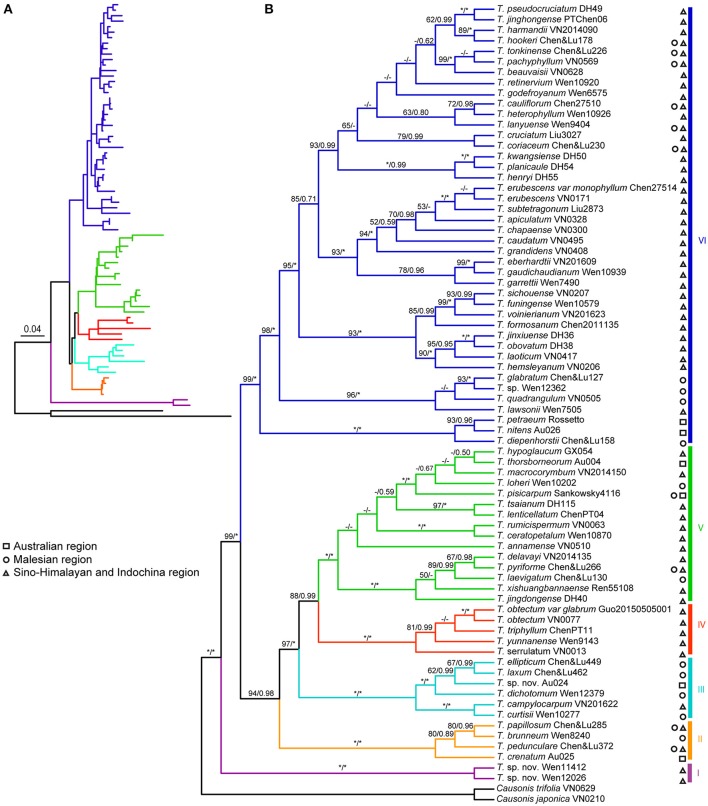
Maximum likelihood (ML) tree for Vitaceae based on the combined 10-cp data set (atpB-rbcL, atpF-atpH, matK, psbK-psbI, rbcL, rpoC1, rps16, trnC-petN, trnH-psbA, trnL-trnF). (A) A phylogram overview is shown in the upper left-hand corner with the scale bar indicating the average number of nucleotide substitutions per site. (B) Six major clades designated in this study are highlighted with different color branches and vertical bars on the cladogram. ML bootstrap and Bayesian PP-values are indicated above branches (“*” represents BS = 100% or PP = 1.00; “–” indicates BS < 50% and PP < 0.5). Biogeographic distribution regions of Tetrastigma follow Chen et al. (2011a,b) and are indicated with symbols at the right of each taxon name: the Australian region (square), the Malesian region (circle), and Sino-Himalayan and Indochina region (triangle).